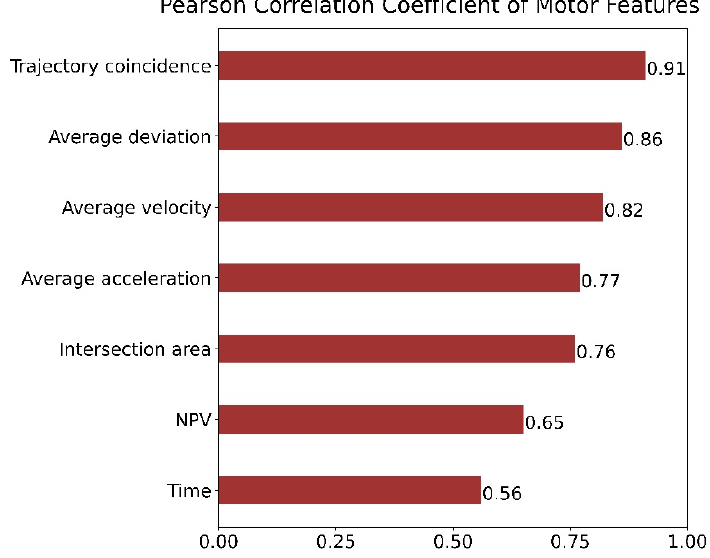
Figure 6. Pearson correlation coefficient of motor features.